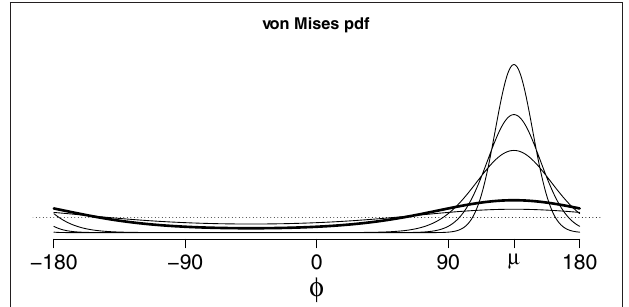
FIGURE 8 | Periodic probability density functions for von Mises distributions centered at µ 135 ◦ (due NW, toward the Belham Valley) with six possible = concentration parameters κ 0, 0.5, 1, 5, 10, 20 . Distribution is more ∈ { } µ ) for larger κ . Thick line is κ concentrated (with higher peaks at φ 1, = = dotted line is κ 0 (uniform pdf on S 1 ) for contrast. =